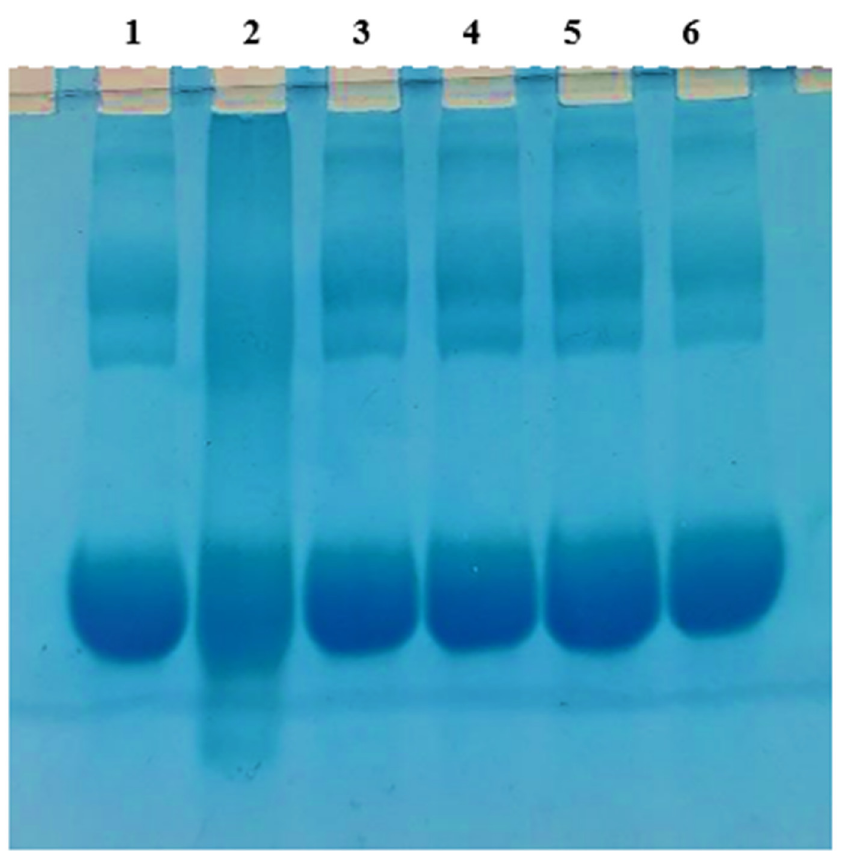
Figure 11. SDS-PAGE of the effects of NSAE on protein aggregation is mediated by glycation of BSA with D-ribose after 28 days of incubation. Samples were incubated with the following: Lane 1: BSA alone; Lane 2: BSA+D-ribose; Lane 3: BSA+AG; Lane 4: BSA+ D-ribose+ AG; Lane 5: BSA+NSAE; Lane 6: BSA+ D-ribose+ NSAE.